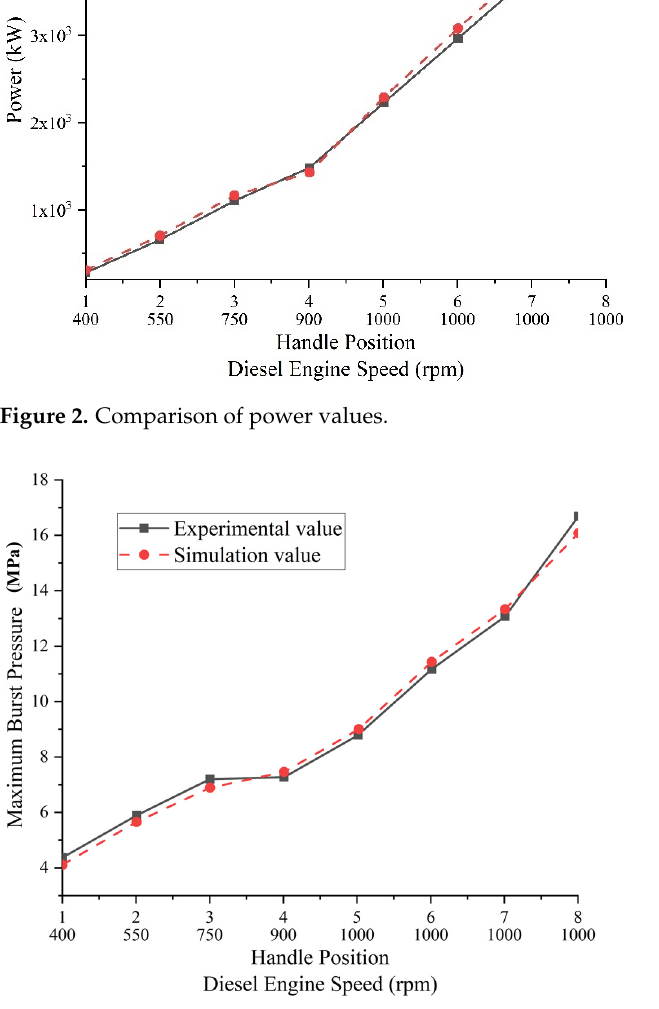
Figure 3. Comparison of maximum burst pressure.